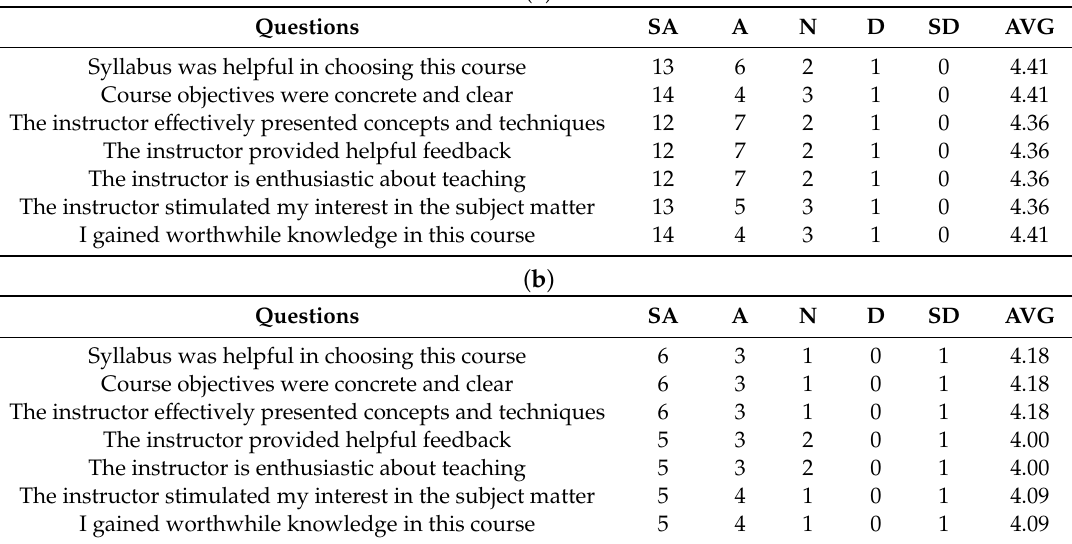
Table 2. Student evaluation results. ( a ) 2018; ( b ) 2019.